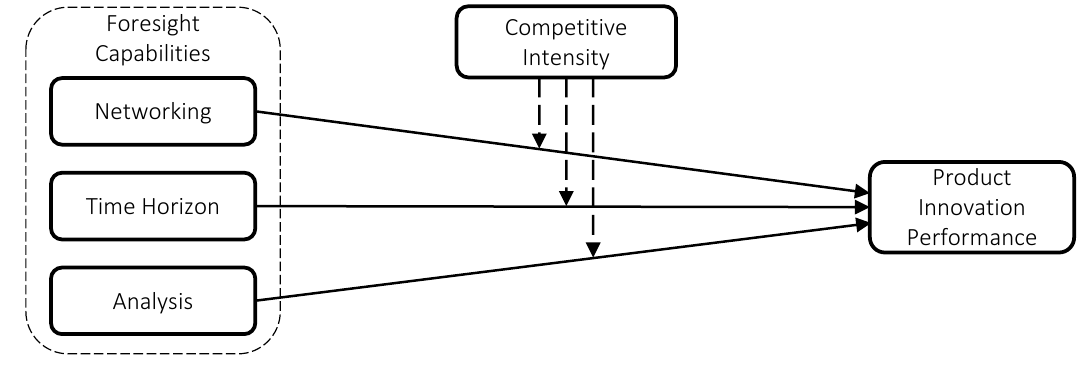
Figure 1. Research